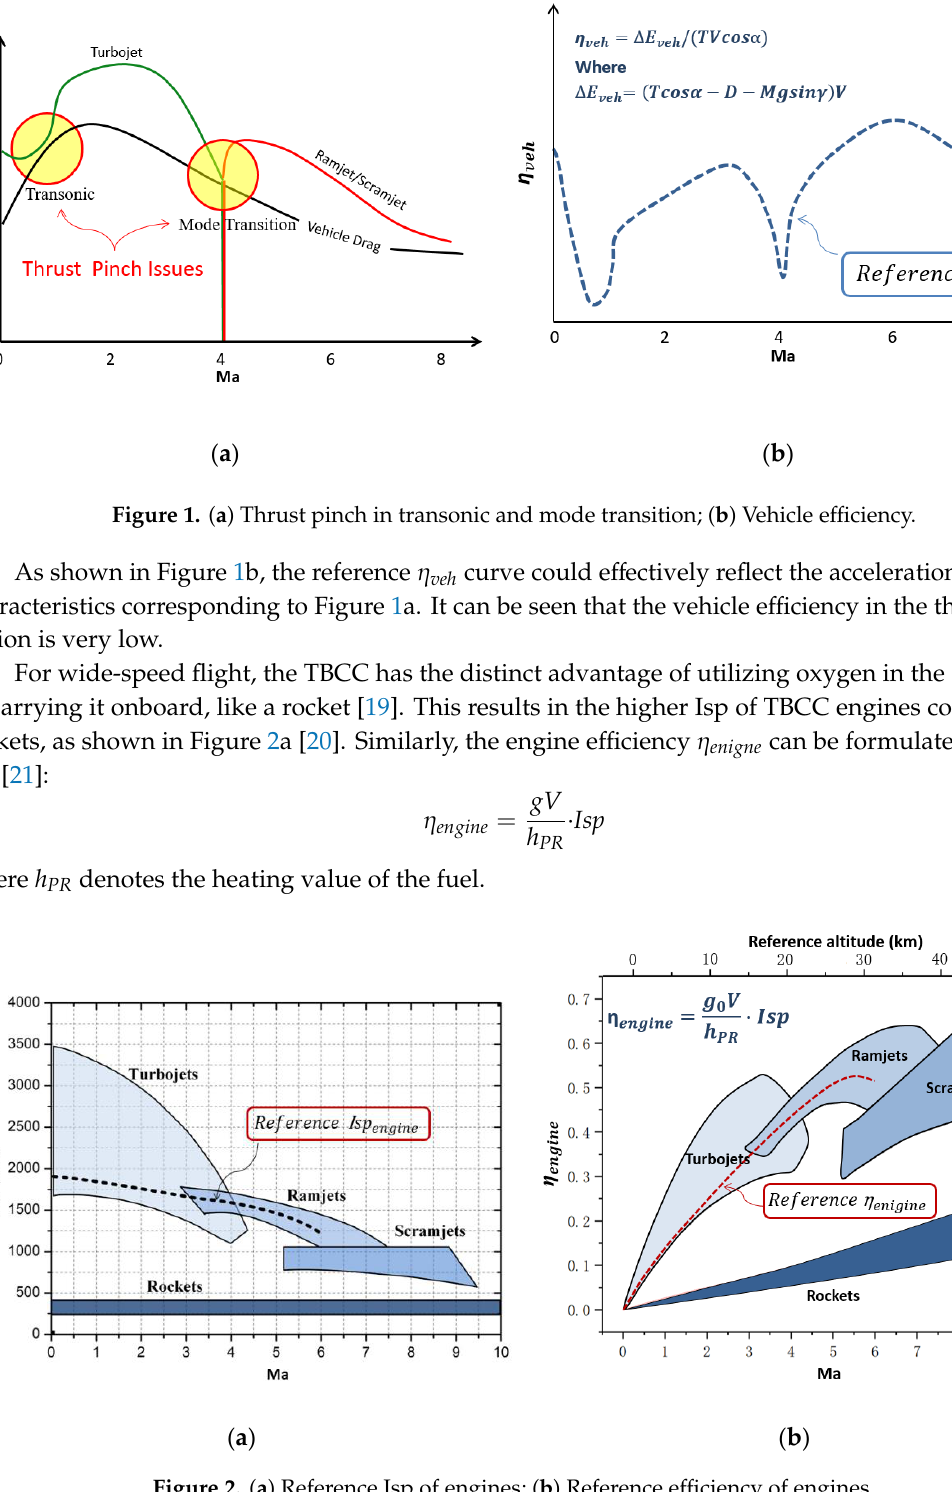
Figure 2. ( a ) Reference Isp of engines; ( b ) Reference efficiency of engines.